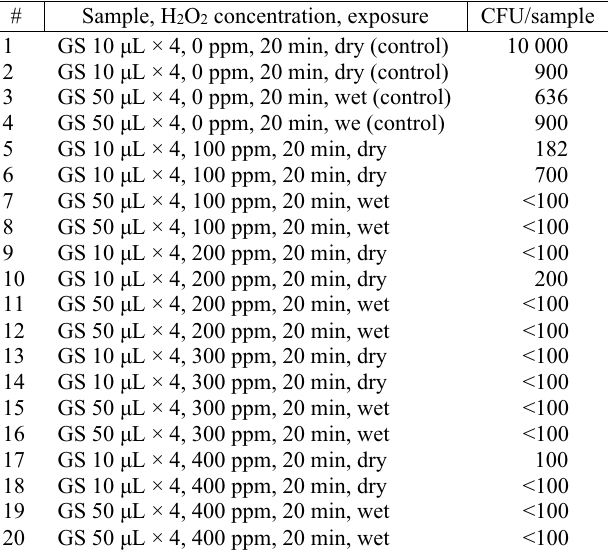
Fig. 2. VHP concentration as a function of time during GS spore decontamination experiments. Violet vertical bars show the beginning and end of exposure for 100 ppm, cyan for 200 ppm, green for 300 ppm and red for 400 ppm VHP concentrations, respectively. Table 1. Results of the classical growth method for all GS